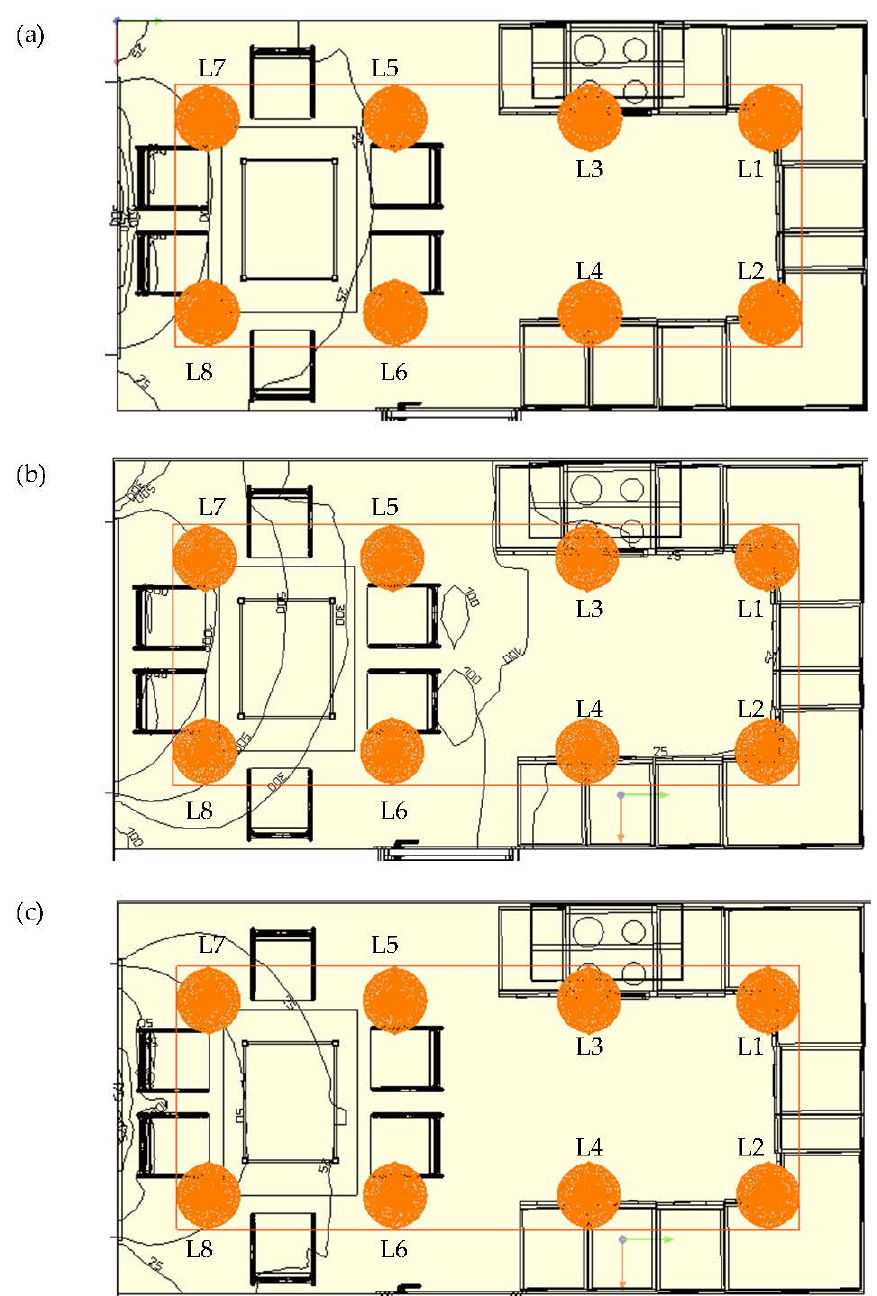
Figure 7. The uneven pattern of the daylight simulation in DIALuxEvo 8.1 ( a ) at sub-scenario A, 6:00 a.m., 1 May 2019; ( b ) at sub-scenario B, 9:00 a.m., 5 June 2019; and ( c ) at sub-scenario C, 4:00 p.m., 10 November 2019.